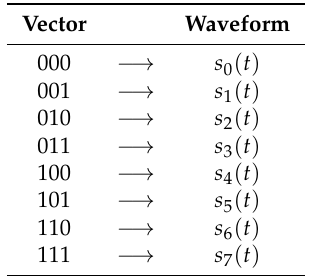
Table 1. Mapping for Modulation Order